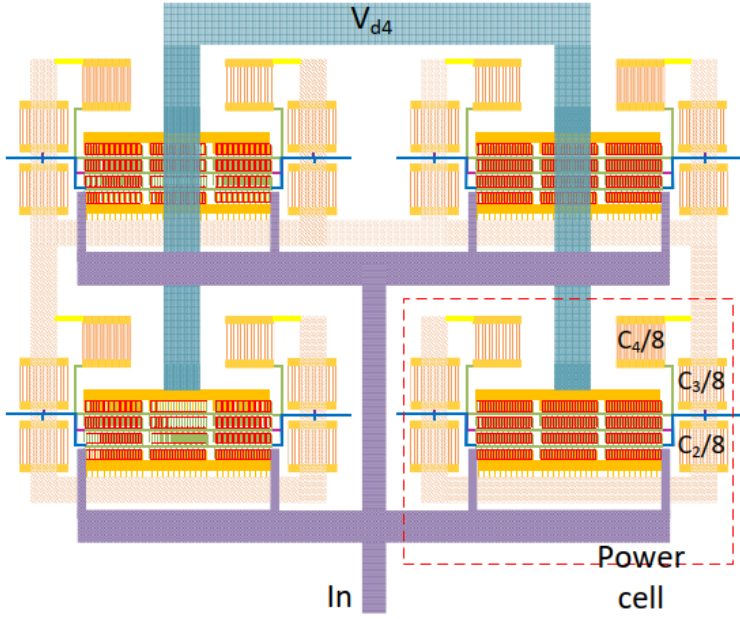
Figure 4. Layout of the PA core of the four-stack